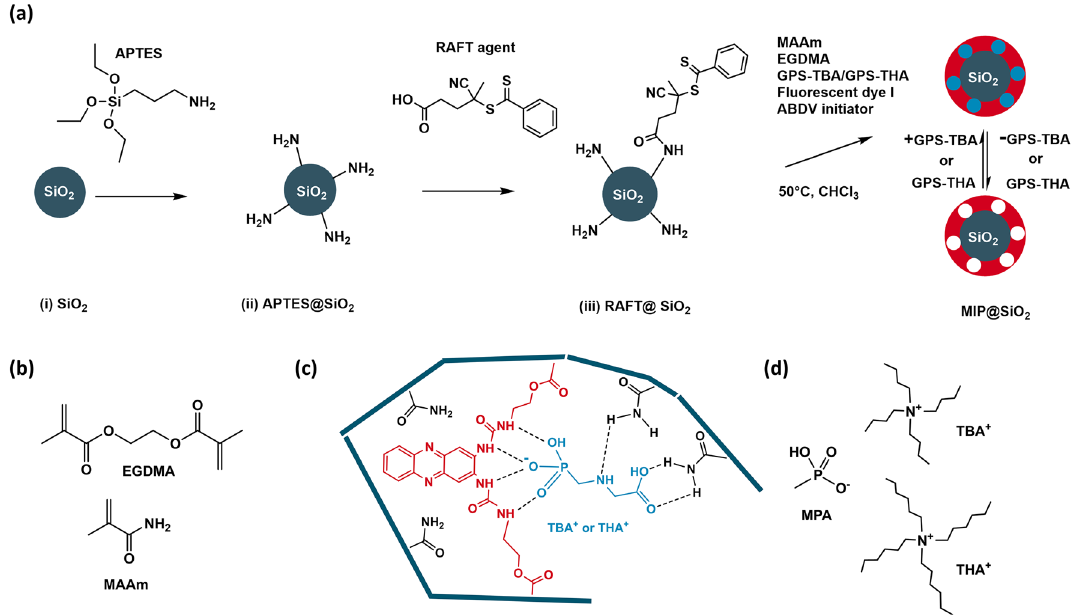
Figure 2. ( a ) Synthesis scheme for MIP particles. ( b ) Comonomer (MAAm) and crosslinker (EGDMA) used in the synthesis of MIP and dNIP particles. ( c ) Incorporation of fluorescent crosslinker, template and comonomer in the polymer matrix. After MIP synthesis, template is extracted to yield binding cavities. Note that hydrogen bonding stabilization by MAAm would happen in a similar way for other possible forms of GPS. ( d ) “Dummy” template (MPA-TBA or MPA-THA) used in synthesis of “dummy”